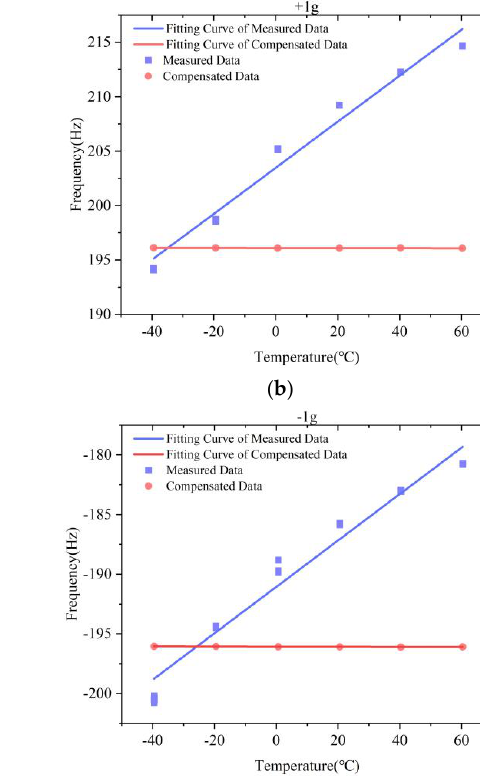
Figure 9. The IFA-BP compensation results of test dataset 1 in the full-temperature experiment: ( a ) +0 g; ( b ) +1 g; ( c ) −0 g; ( d ) −1 g.